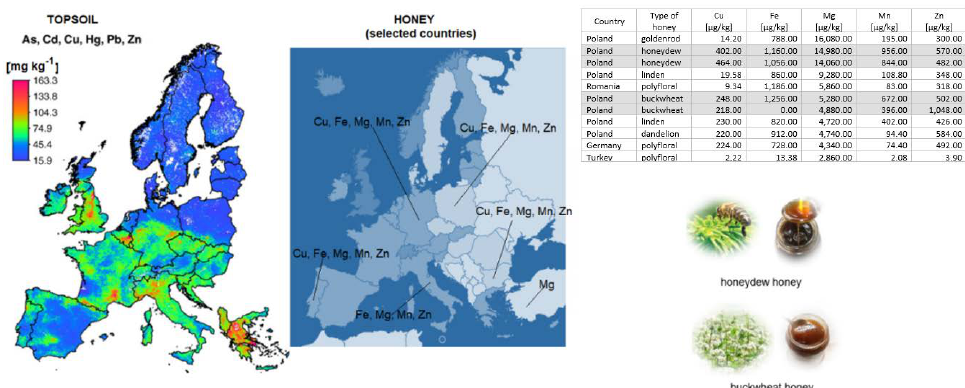
Figure 6. Exemplary results of macro- and microelements concentration in honey samples and maps of heavy metal concentrations in topsoil in Europe, partially according to [33]. Reprinted/adapted with permission from Ref. [33].